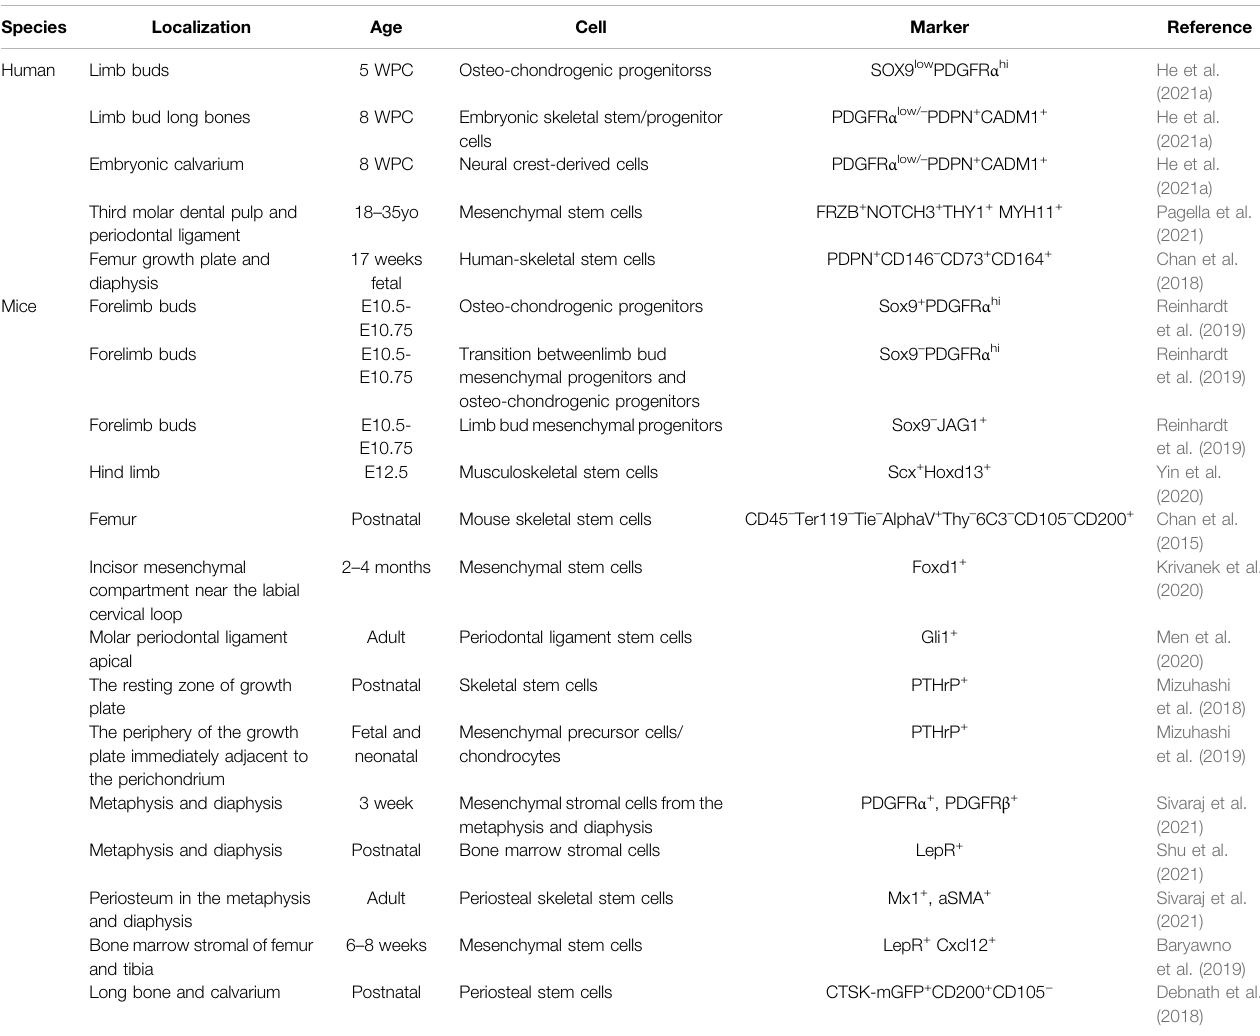
TABLE 1 | Characterization of embryonic and hard tissue-derived stem/progenitor cell (WPC, weeks post conception; yo, years old).